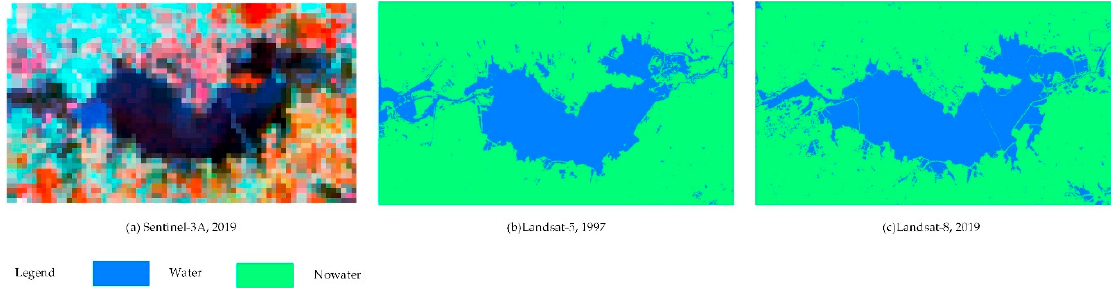
Figure 7. Data used in Experiment 2: ( a ) current Sentinel-3A OLIC image, 2019; ( b ) previous water body map (Landsat-5, 1997); ( c ) reference map (Landsat-8, 2019).